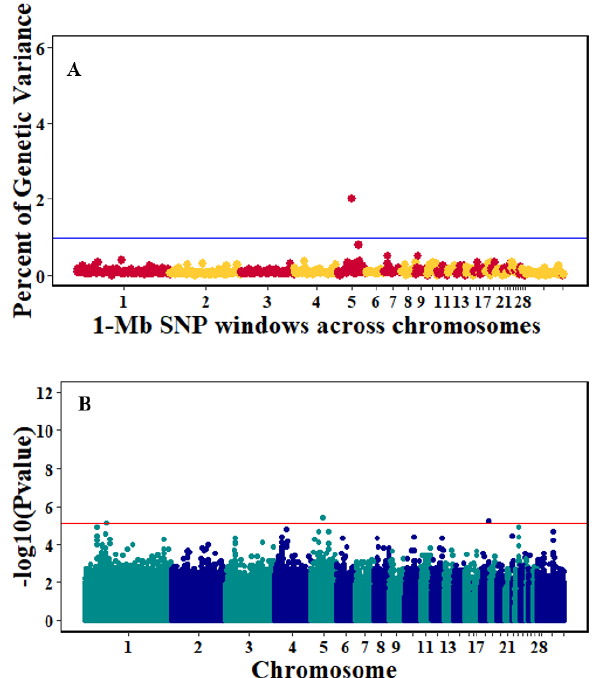
using Bayes-B and single-SNP analyses. ( A ) Bayes-B results show the percent of genetic variance explained by 1-Megabase (1-Mb) nonoverlapping windows of SNPs across chromosomes. ( B ) Single- SNP results show the − log 10 ( P value) of ordered SNPs across the chromosomes. The blue and red lines indicate genome-wide significance at 1% genetic variance and 20% suggestive adjusted Bonferroni correction, respectively.